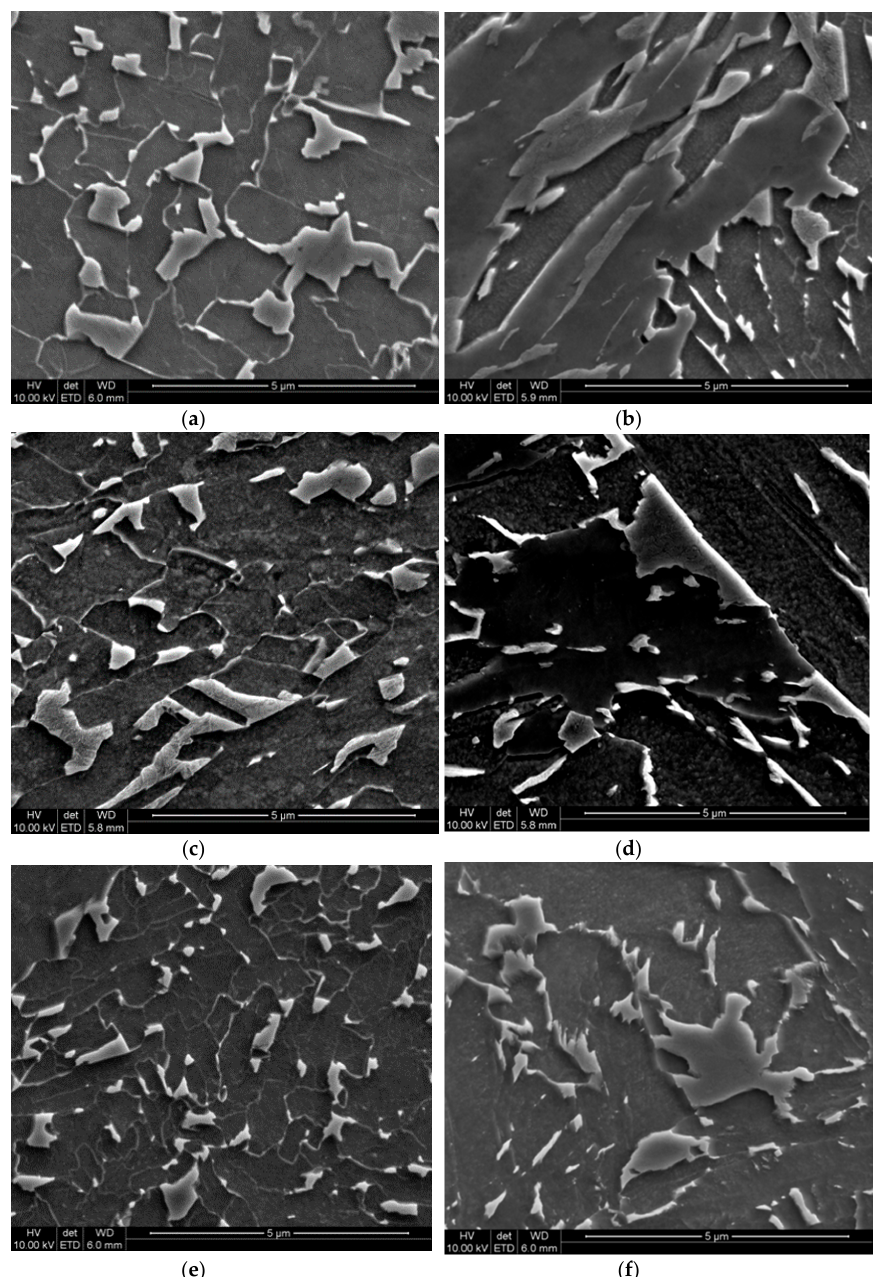
Figure 5. Sample images of the microstructure for heat S405 ( a , c , e ) and S406 ( b , d , f ) at PSC deformation, variant 2a ( a , b ), variant 2b ( c , d ) and variant 2c ( e , f ). AHSS. Based on the different simulated schedules (Figure 2d), microstructures and mechanical